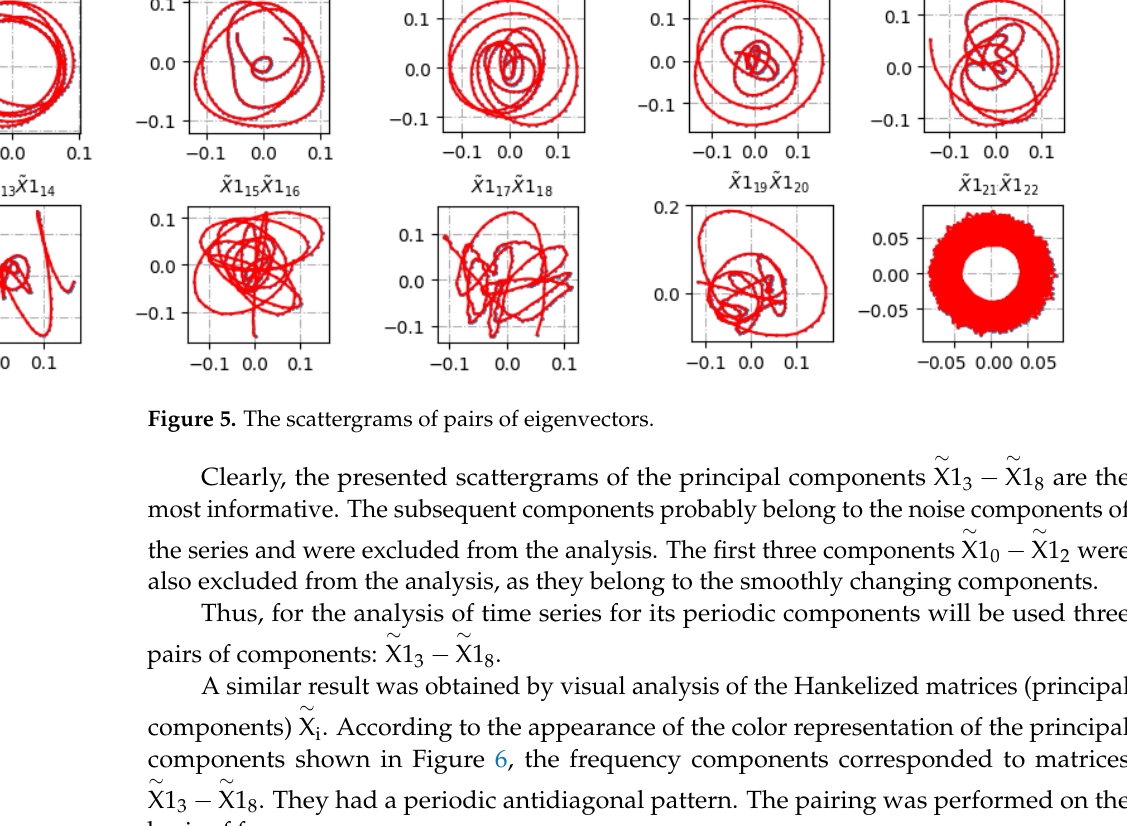
Figure 6. The Hankelized matrices of principal component.